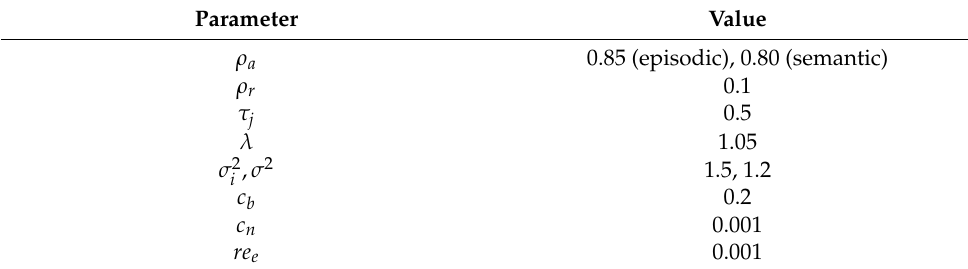
Table 3. Parameter setting for the proposed MCMS.